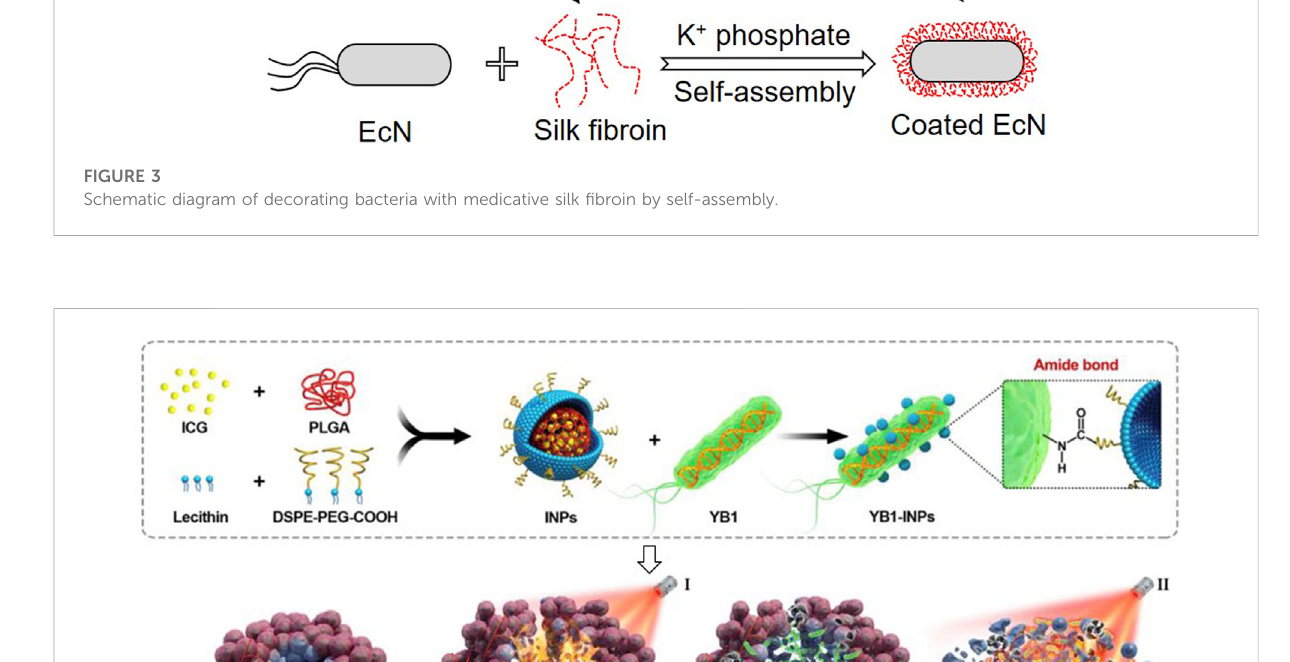
Frontiers in Bioengineering and